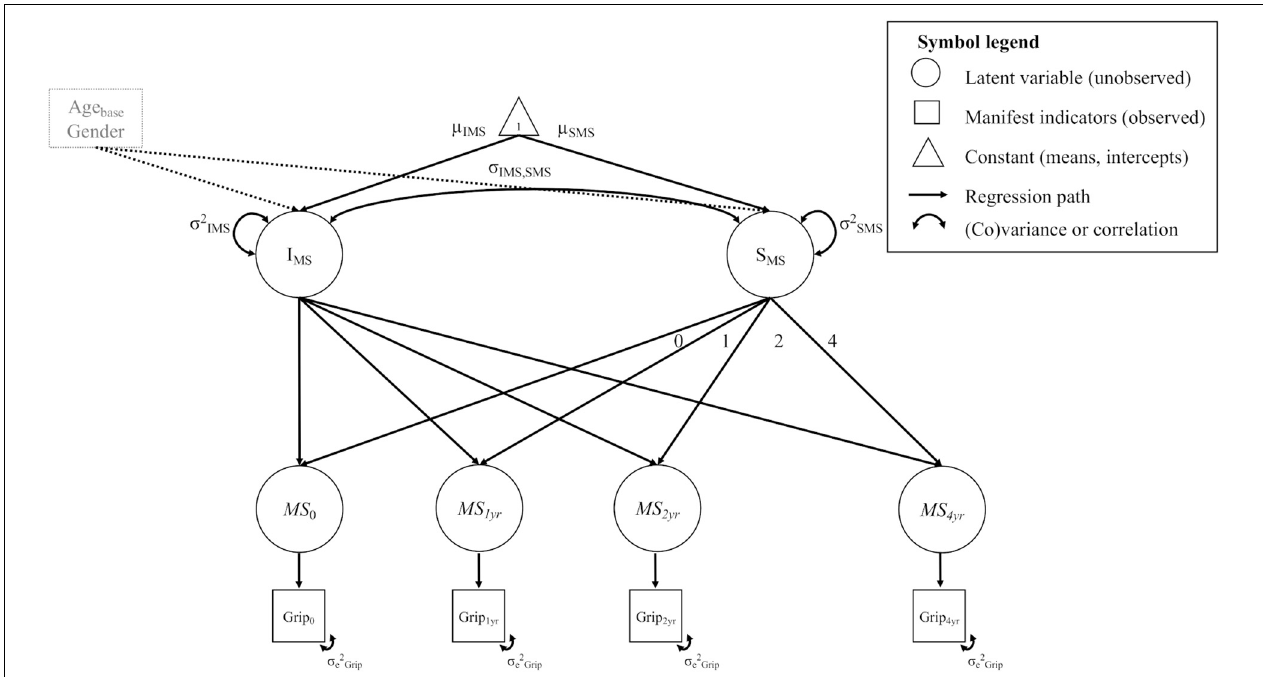
FIGURE 1 | Example diagram of a univariate LGC model for motor strength (MS) in the grip force test (Grip). For a detailed description see methods section (univariate models). All unlabeled paths are fixed to 1. Parameters with the same label are fixed to be equal. The manifest indicator intercepts are not shown for visual clarity. Intercept and slope variance is controlled for age at baseline (Age base ) and